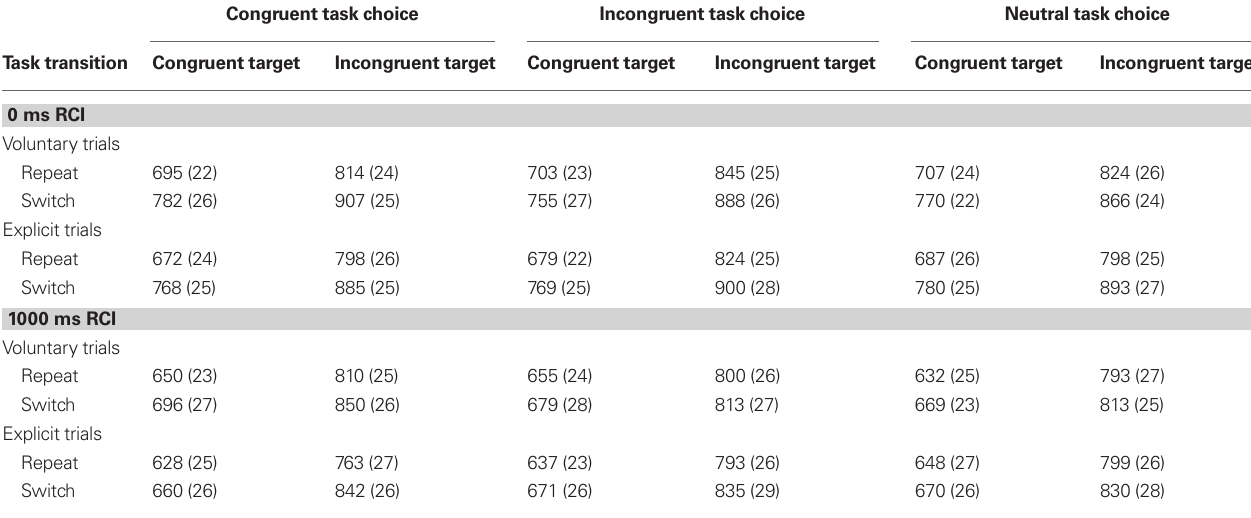
Table 2 | Mean reaction time (ms) in the main conditions of the study.